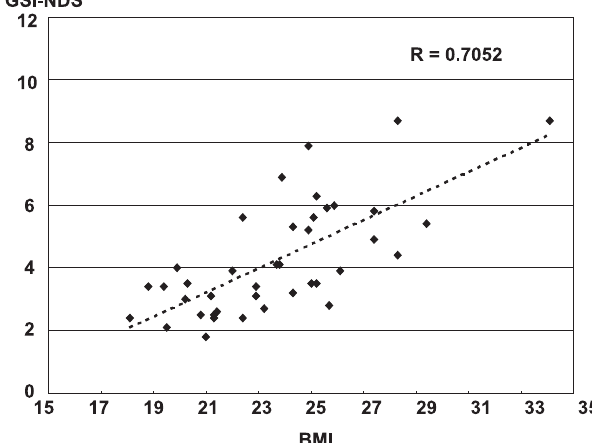
Figure 3 - Correlation between the general stability index on the non-dominant side (GSI-NDS) and the body mass index